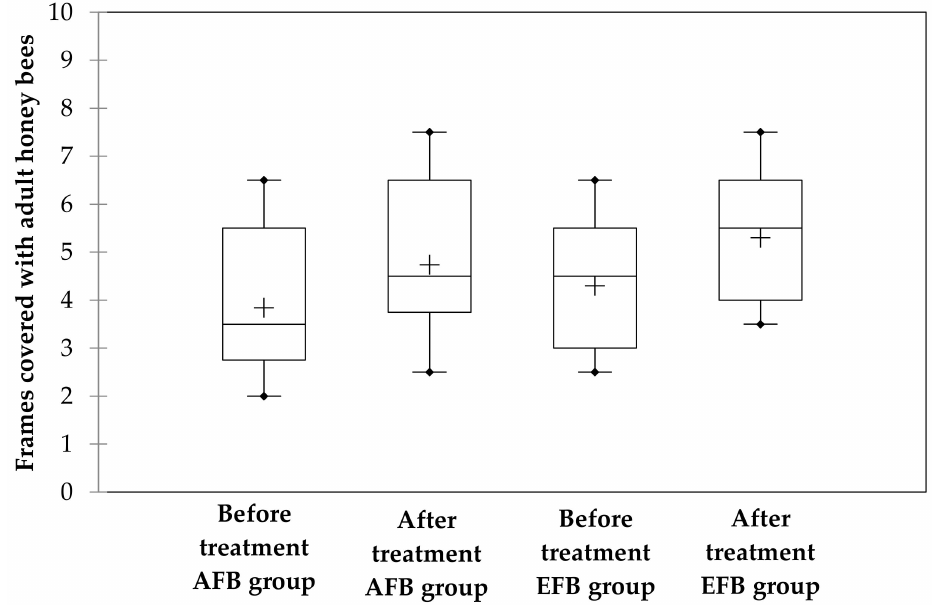
Figure 2. Box plot of colony strength before and after treatment in the AFB and EFB groups. + sign is the mean